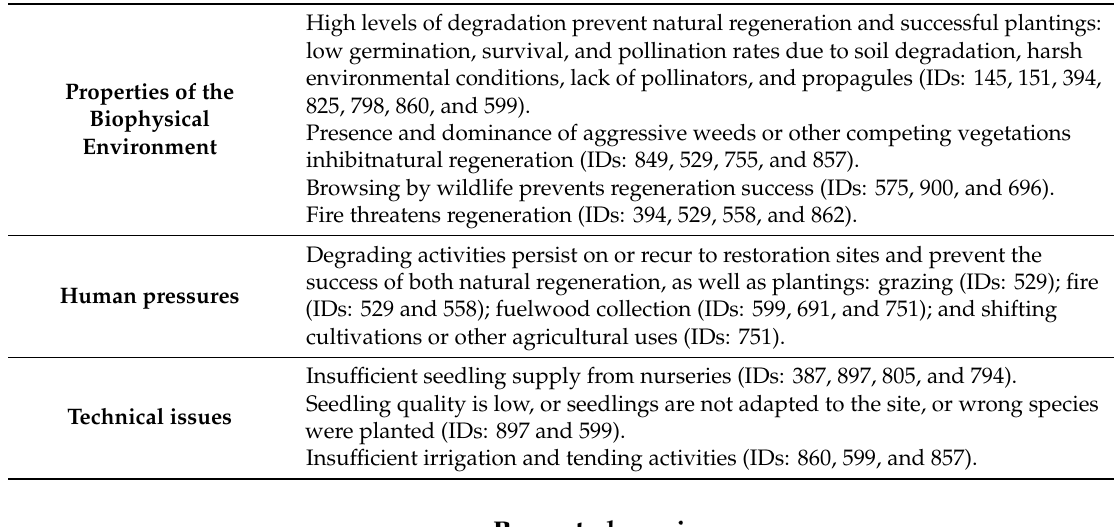
Table 3. Obstacles to forest / tree regeneration reported by respondents.